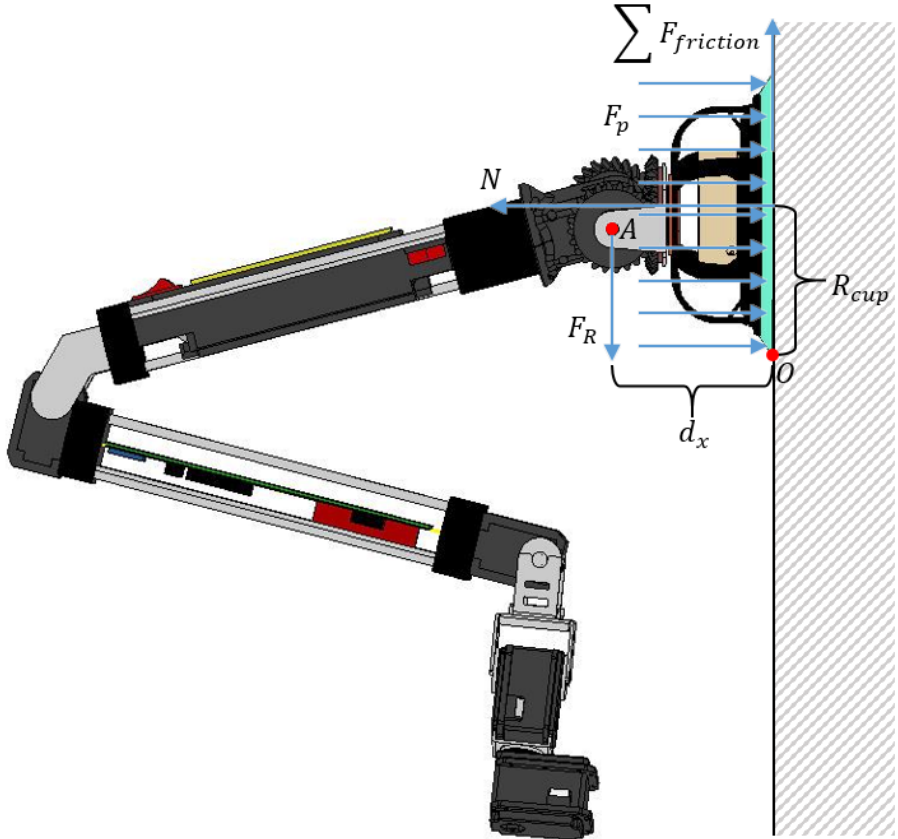
Figure 5. Physical model of ROMERIN robot with vacuum generation